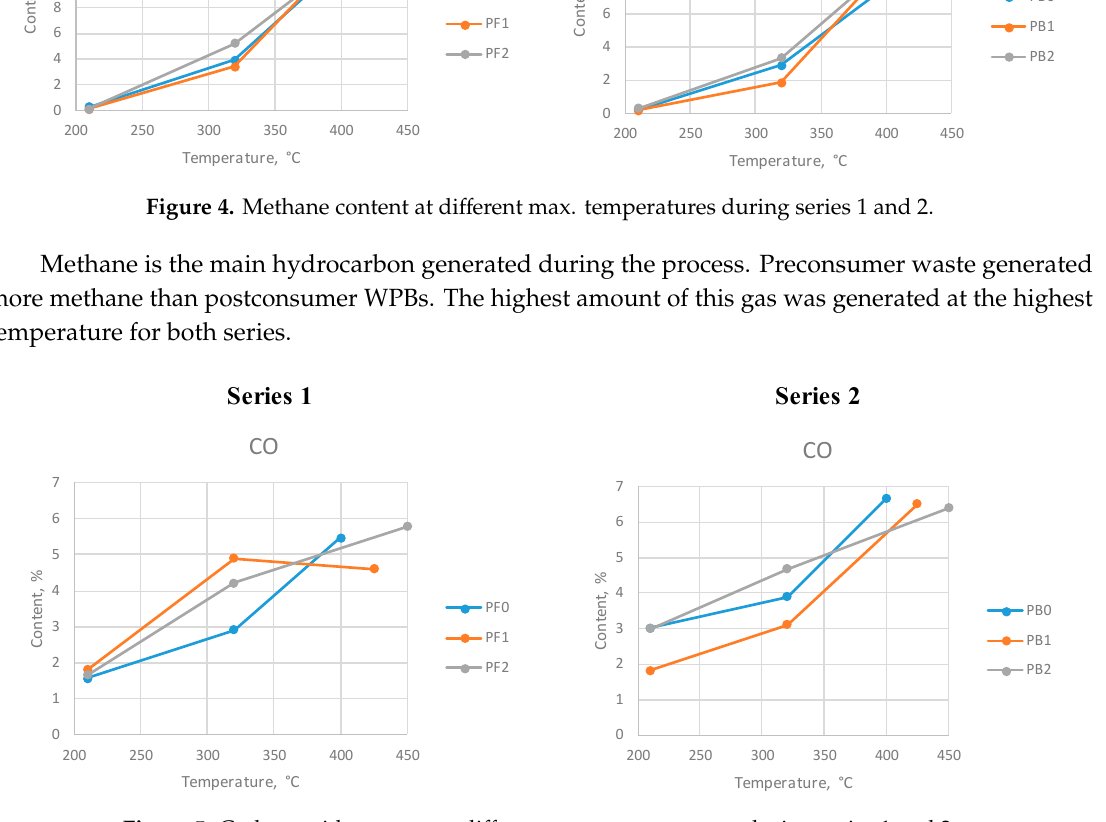
Figure 5. Carbon oxide content at different max. temperatures during series 1 and 2.